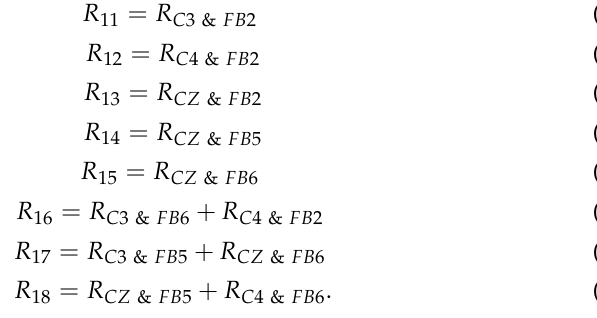
Table 6. Selection features of all features based on methods and channels (C3 = 8, CZ = 10, and C4 = 12).